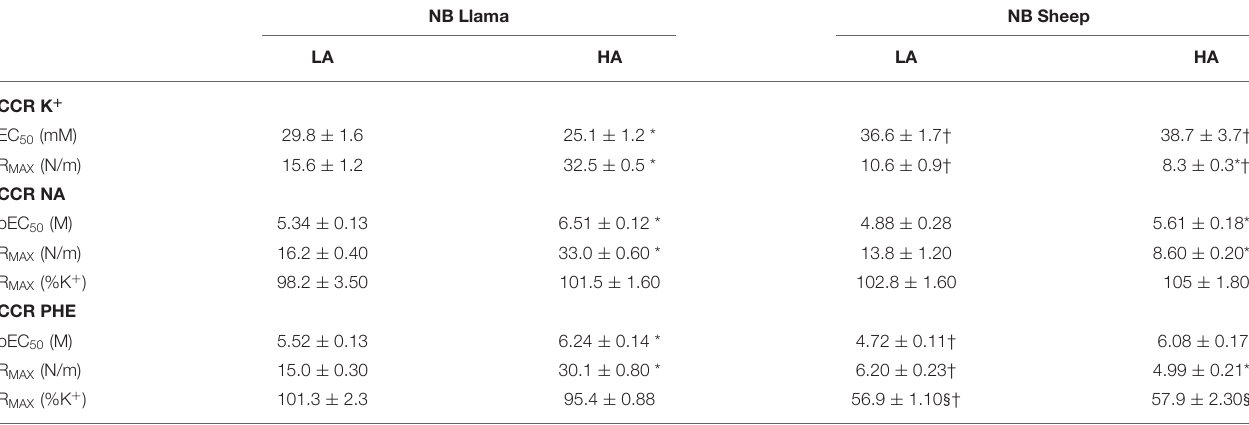
TABLE 1 | Values of CRC in presence of potassium chloride, noradrenaline (NA), phenylephrine (PHE) in NBLL and NBSH at LA and HA. NB